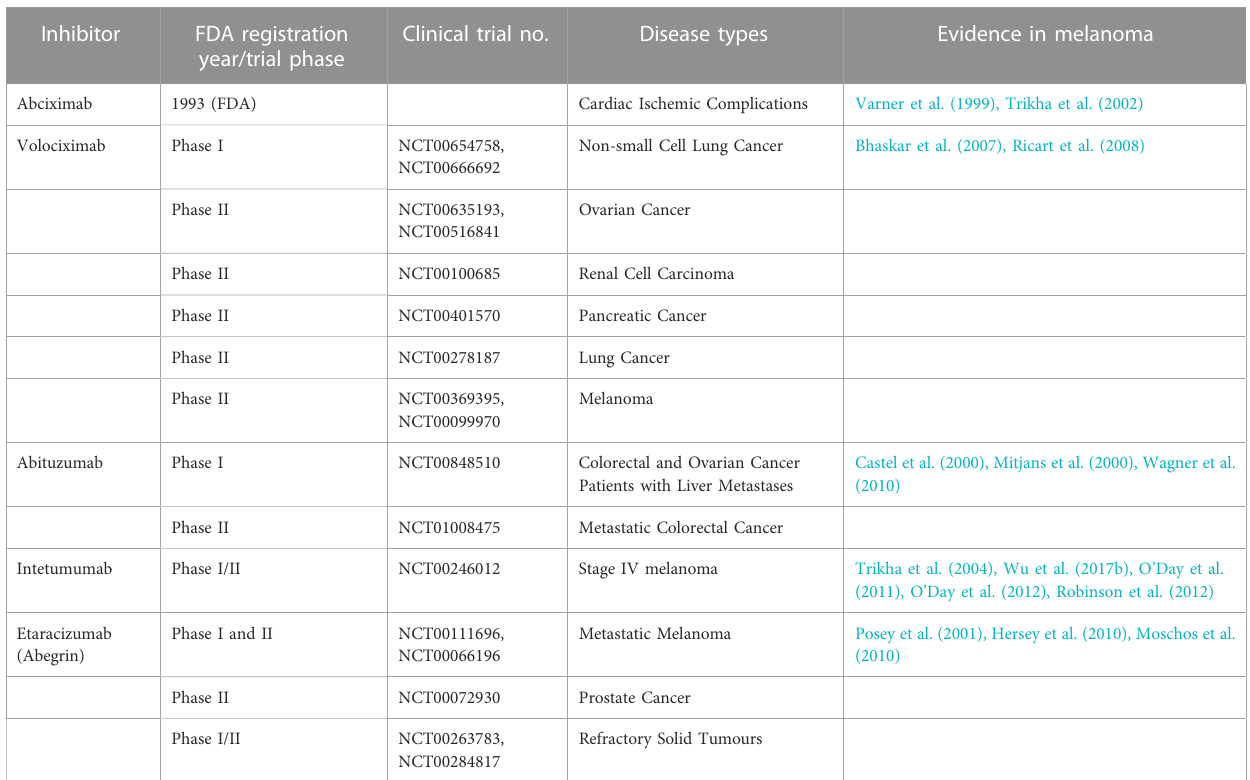
TABLE 1 Monoclonal antibody therapies targeting